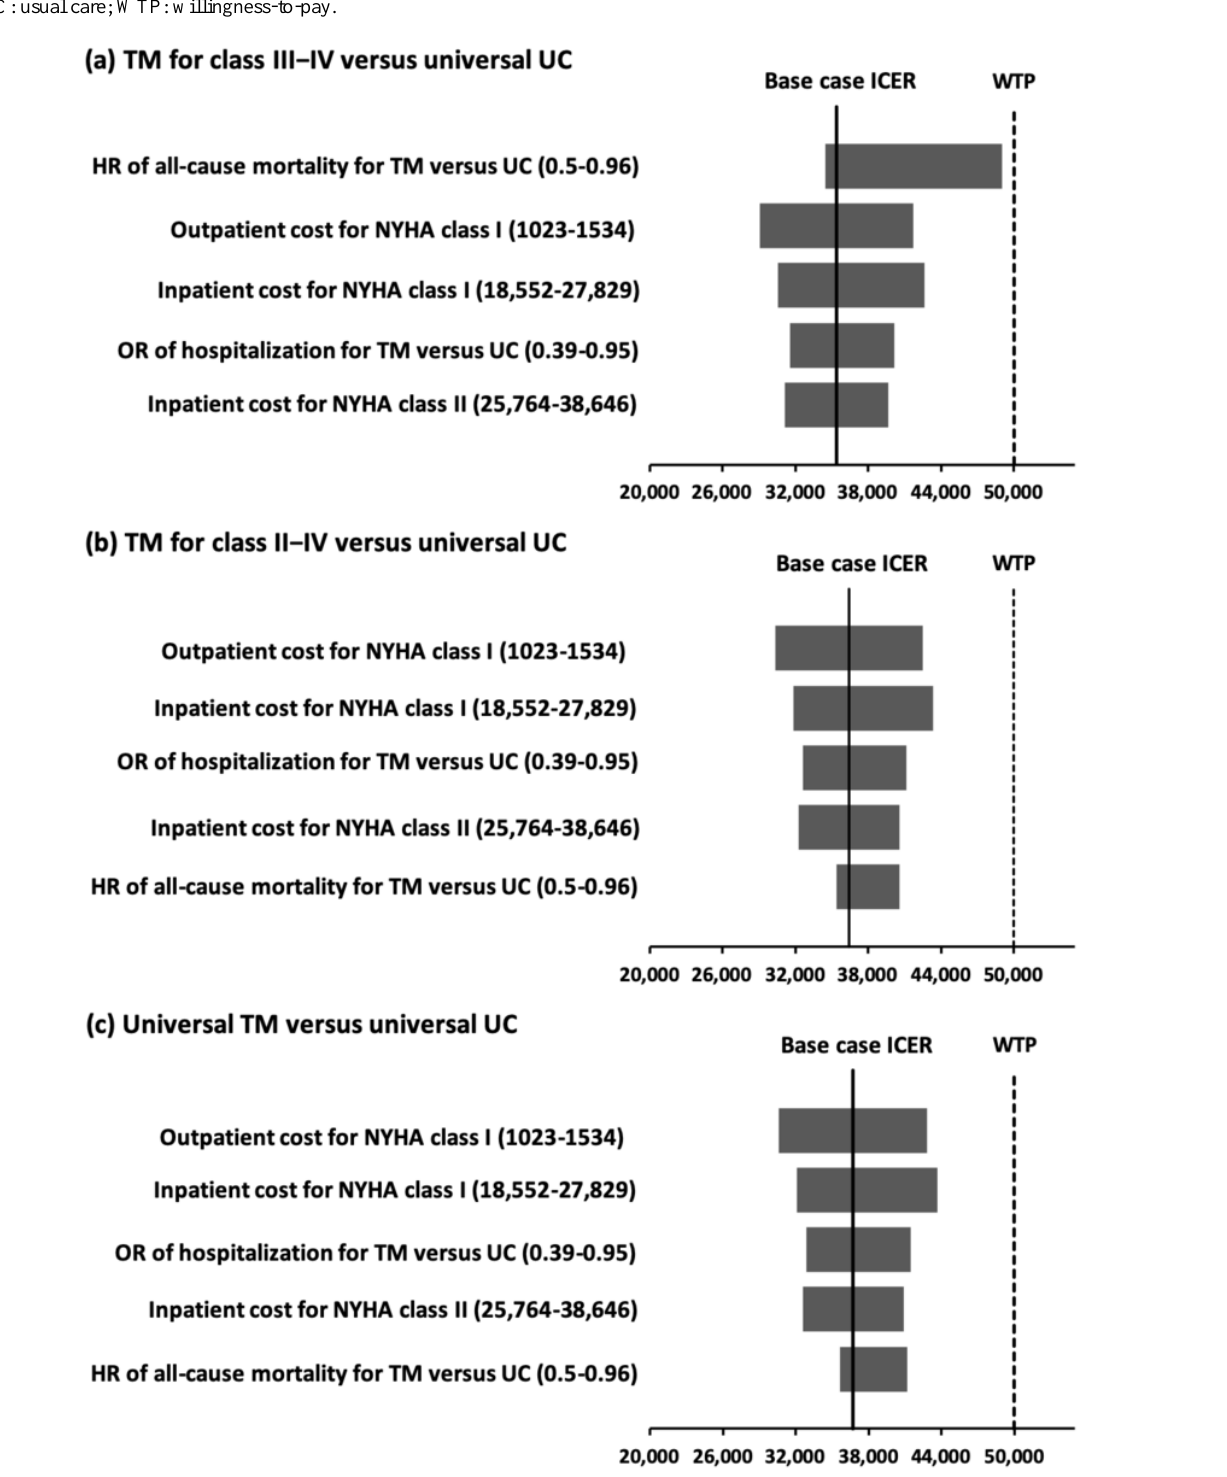
Figure 2. Tornado diagrams: (A) TM for class III to IV versus universal UC, (B) TM for class II to IV versus universal UC, (C) universal TM versus universal UC. HR: hazard ratio; ICER: incremental cost-effectiveness ratio; NYHA: New York Heart Association; OR: odds ratio; TM: telemonitoring; UC: usual care; WTP: